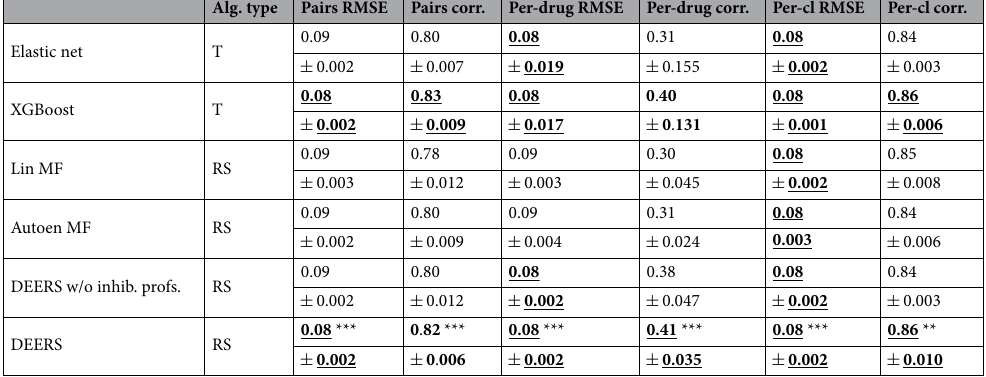
Table 1. Predictive performance of DEERS and compared models when using IC50 as a drug response metric. The presented values are averages of metrics taken across several experiments (ten for DEERS and five for each other method), with different data splits, along with the corresponding standard deviations. The presented per-drug and per-cell line results are medians taken across all considered drugs and cell lines, respectively. The evaluated models are split into two categories: frequently used, traditional machine learning algorithms (T) and recommender system class (RS). Best results within a model category are highlighted with bold font, while the best results overall are underlined. Asterisks indicate the intervals containing the p-values of the one-sided Wilcoxon rank-sum tests of the better performance of DEERS over the other two RS models: no asterisks – [0.05, 1), * – [0.01, 0.1), ** – [0.001, 0.01), *** – (0, 0.001). Abbreviations: Alg. – algorithm, corr. – correlation, cl – cell line, w/o inhib. profs. – without inhibition profiles.